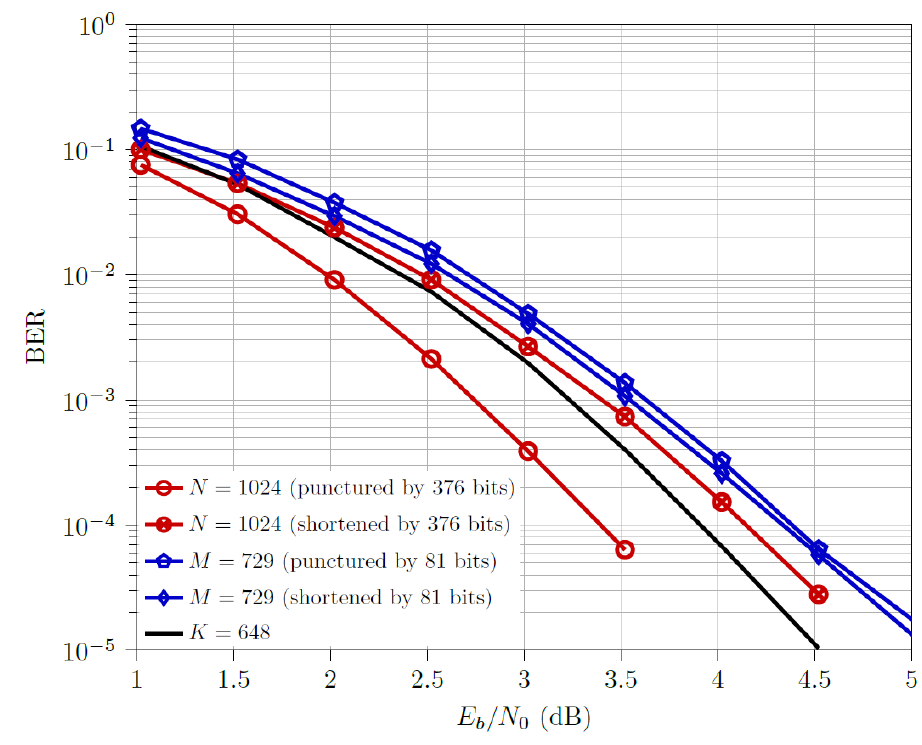
Figure 3. BER performance of Scenario 1 for R d =